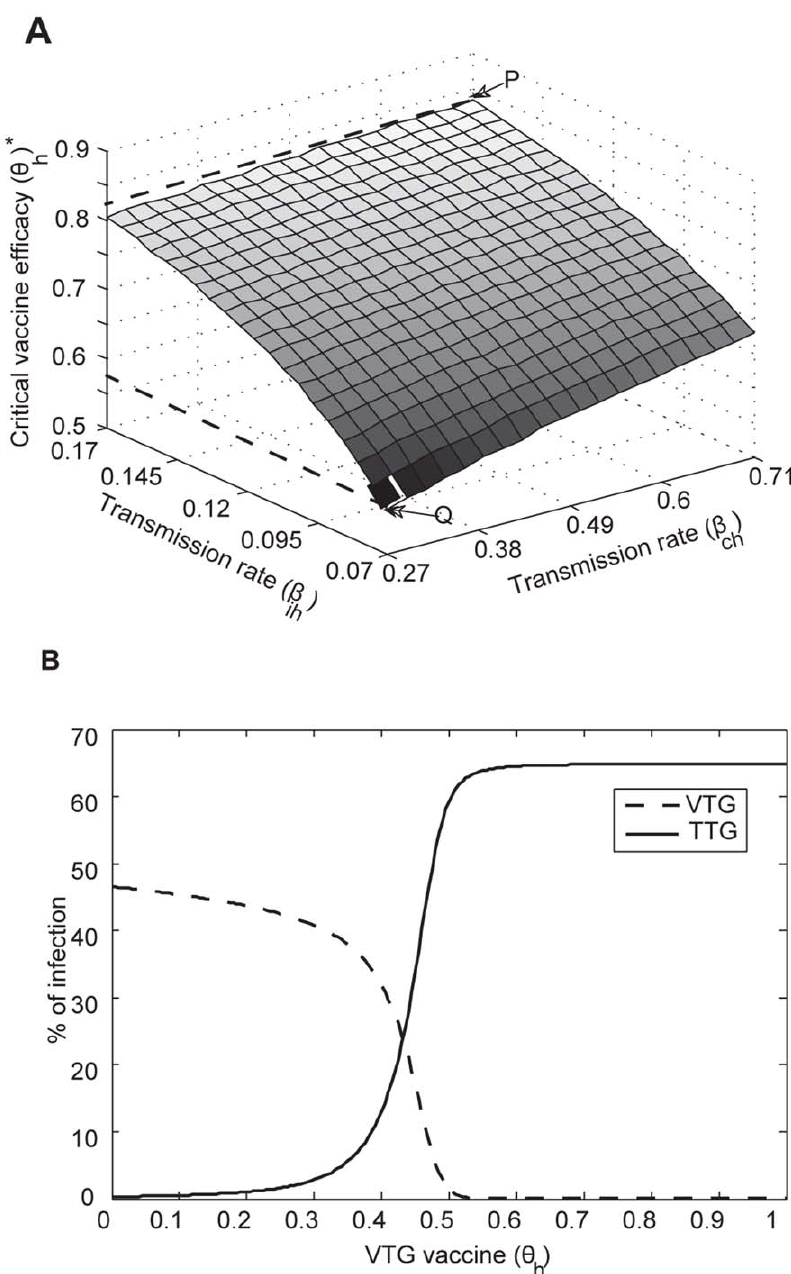
Figure 1. The effect of vaccination on the dynamics of VTG-MRSA in absence of treatments against TTG-MRSA. (A) Critical vaccination ) required to eliminate VTG-MRSA with varying values of transmission rates ( b ch and b ih ). Points P and Q show the critical values efficacy values ( h (cid:2) h required to stop VTG outbreaks in highest and lowest transmission values, respectively. (B) The effect of vaccine and competition, when VTG has = 5.91) compared to TTG ( R L = 4.11). As the efficacy of vaccine increases VTG is replaced by TTG. higher R 0 ( R H 0 0